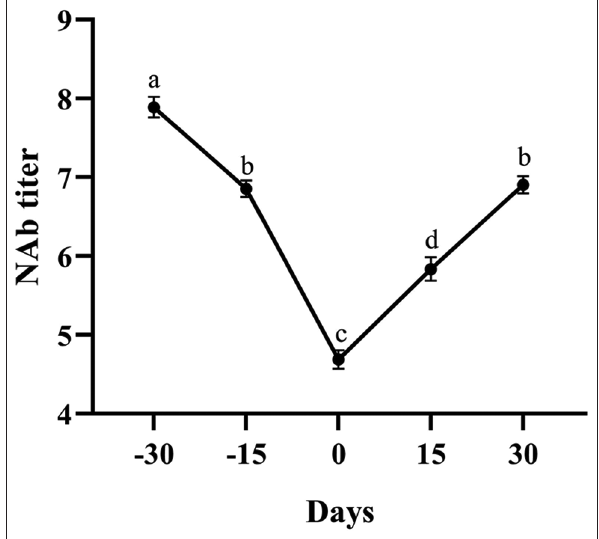
Figure-1: Serum natural antibody titers in all